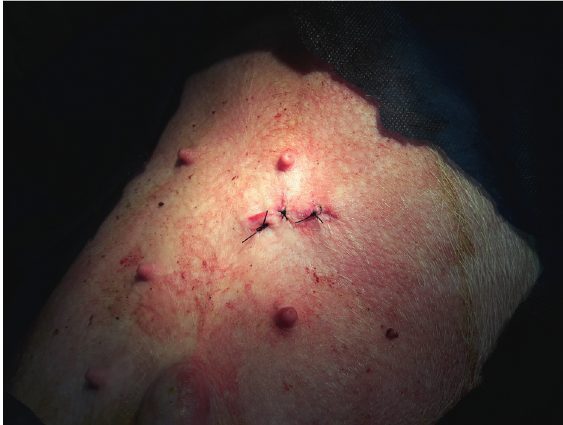
Figure 4 - Skin closure after Single-port Intragastric Sleeve in